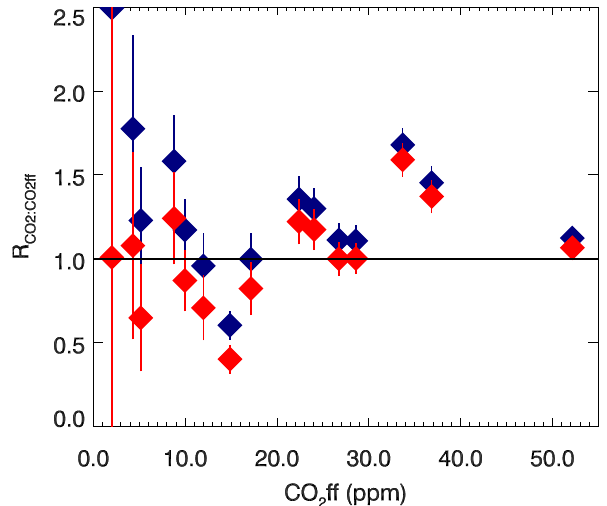
Figure 5. R CO in each flask sample. Blue points use the 2 : CO 2 ff assigned CO 2 background values, red points apply a 3ppm bias to the CO 2 background values in calculating R CO 2 : CO 2 ff